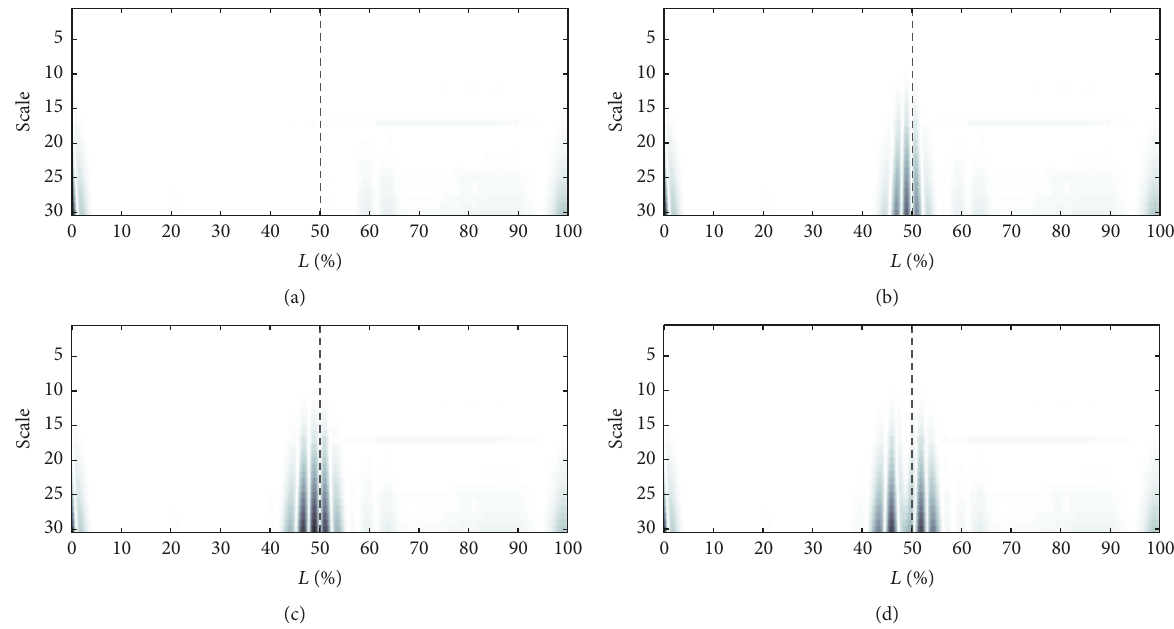
Figure 13: Numerical results of wavelet analysis of the 2nd mode on natural vibrations in the case of the intact and three damage scenarios.